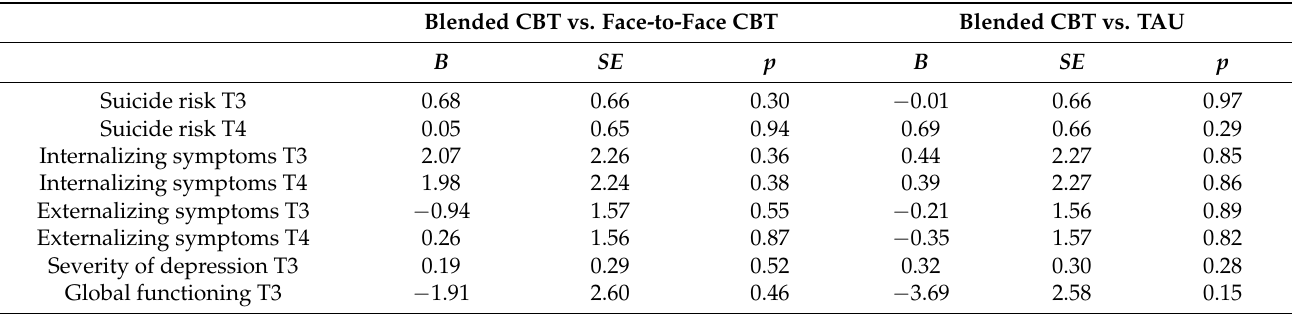
Table 3. Linear mixed model results of interaction terms between condition and time, on suicide risk, internalizing symptoms, externalizing symptoms, severity of depression and global